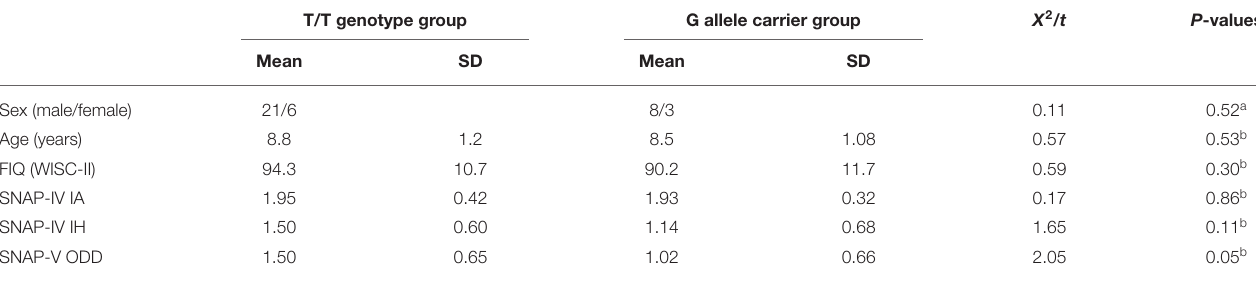
TABLE 2 | Comparison of basic information in the two genotype groups.